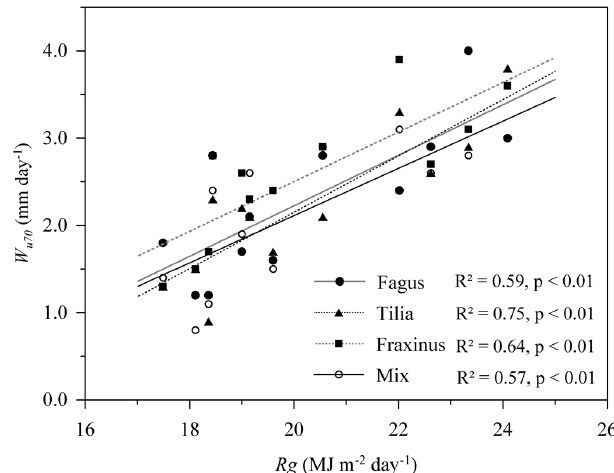
Figure 4. Average Wu 70 as a function of daily global radiation ( Rg ) for 4 di ff erent species combinations ( n = 4 per species combina- tion). Shown are data of 11 measurement occasions from June to mid-September 2009 when trees were fully foliated and linear re- gression models between average Wu 70 and radiation.